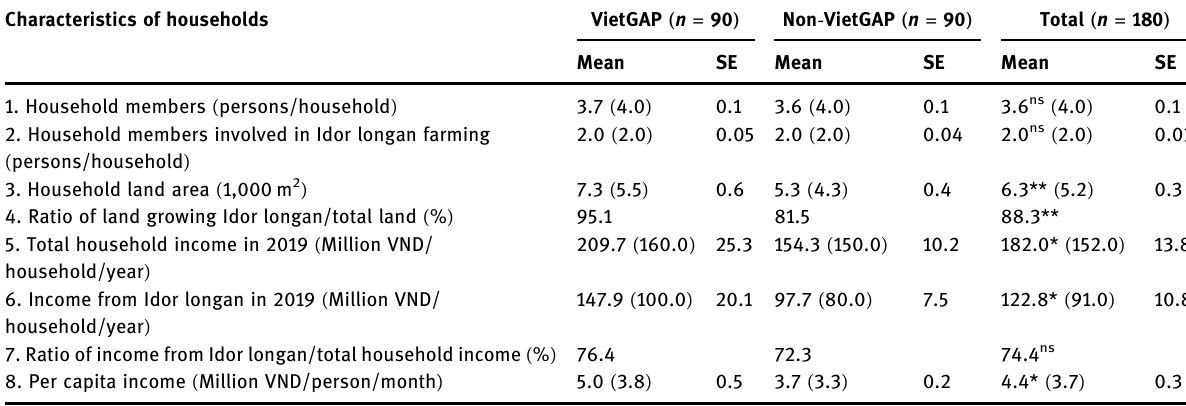
Table 2: Household characteristics of Idor longan growers in the Mekong Delta, Vietnam Characteristics of households